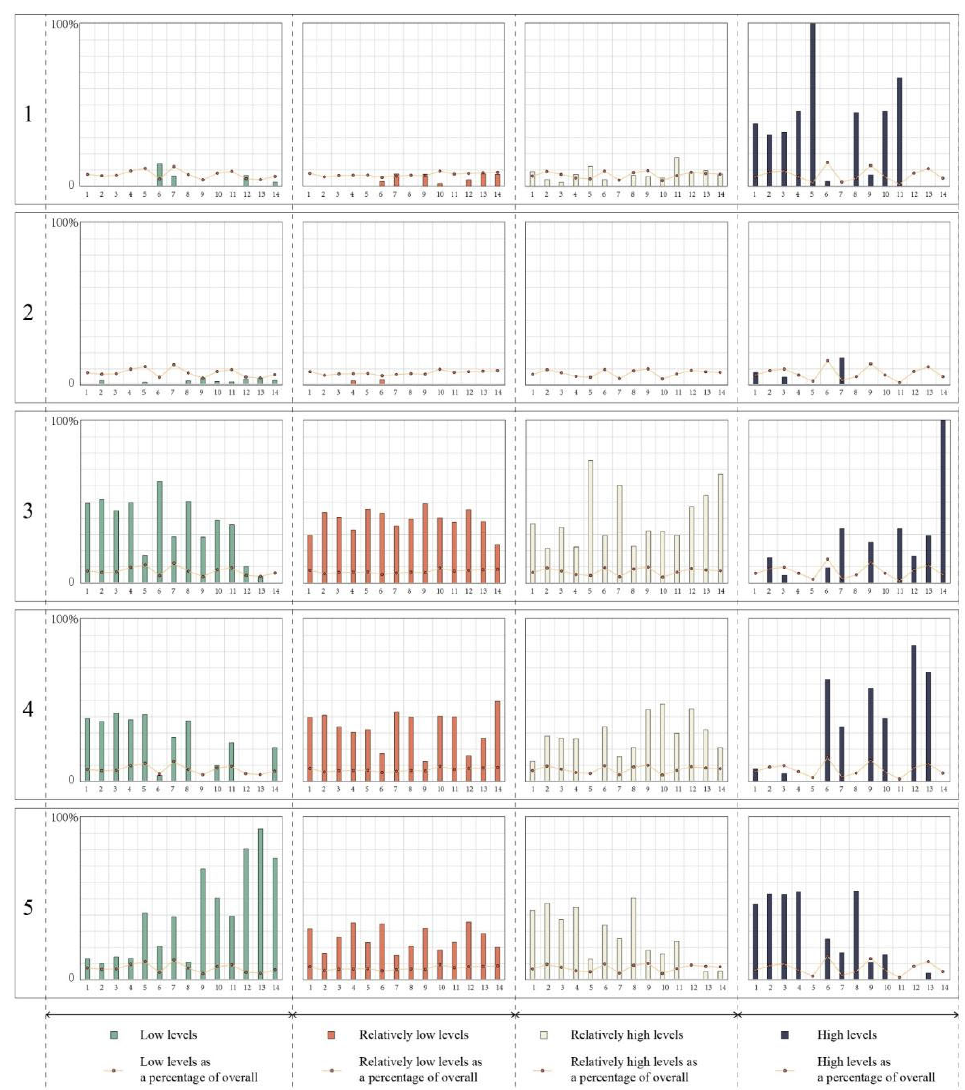
Figure 12. Identification of features quantified (cluster) and overall level (dashes) of the five catego ‐